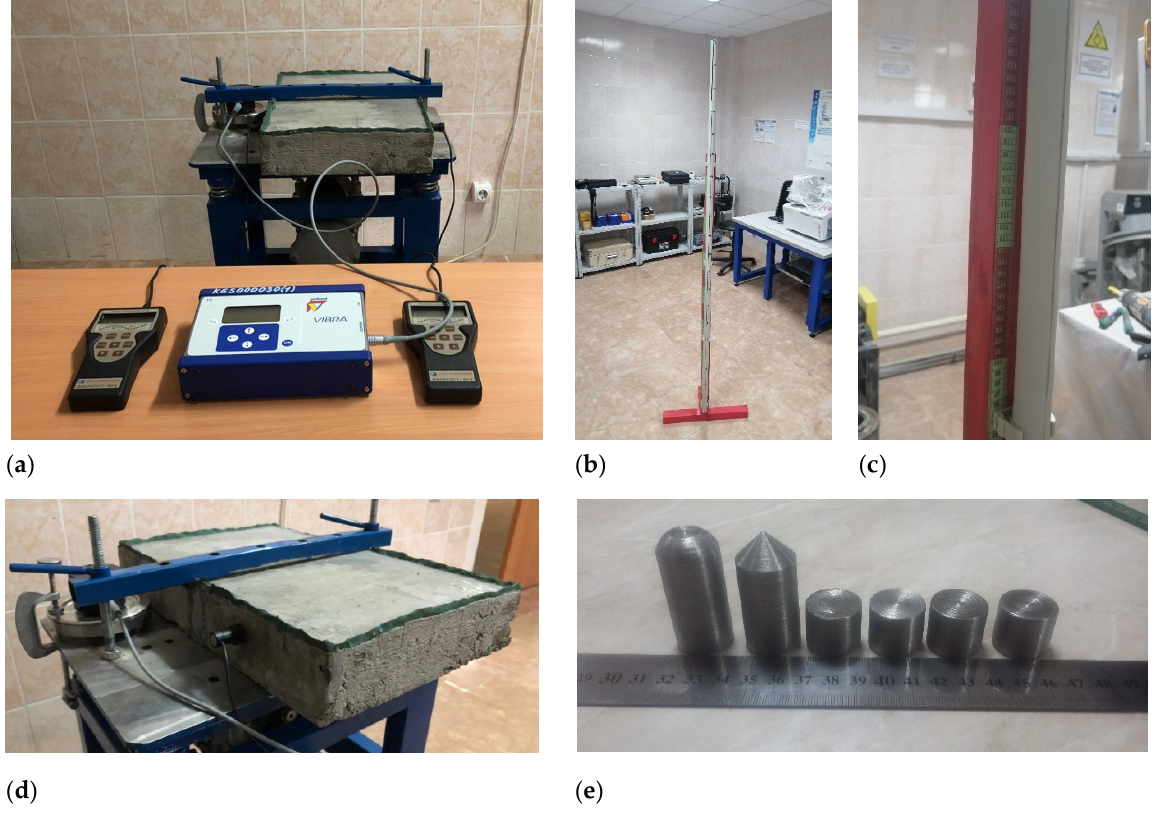
Figure 3. Test of specimens by